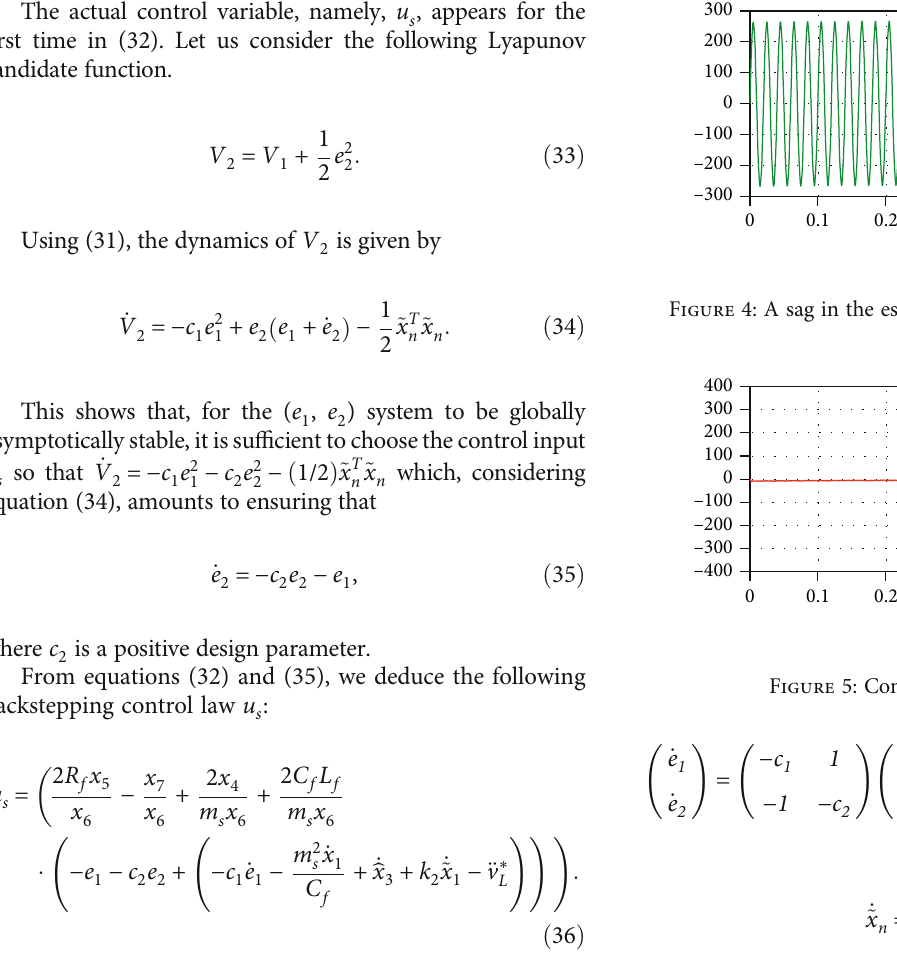
and its estimated ̂ x 2